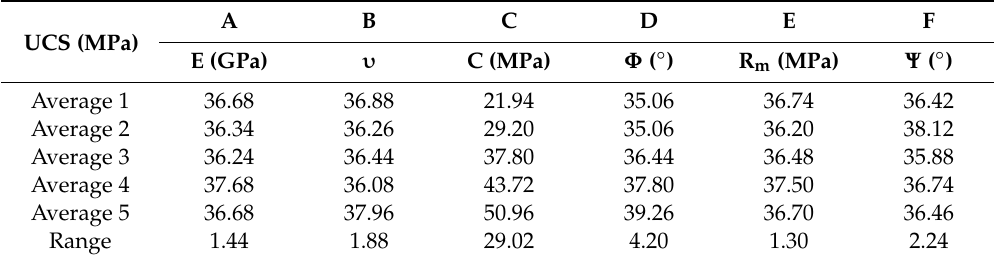
Table 5. Average and range for di ff erent values of each parameter.